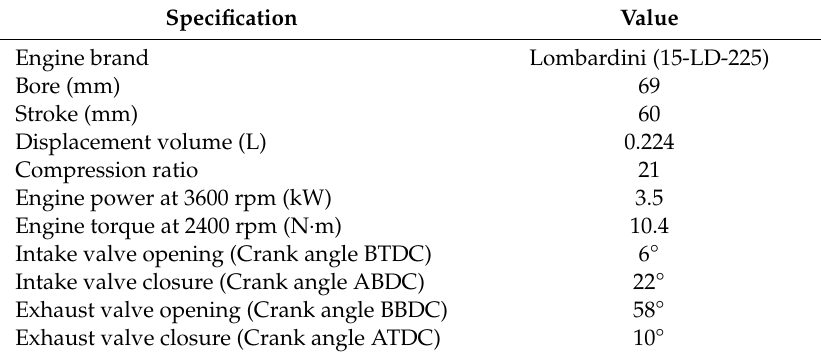
Table 4. Technical data of the exhaust gas analyzer (EMS